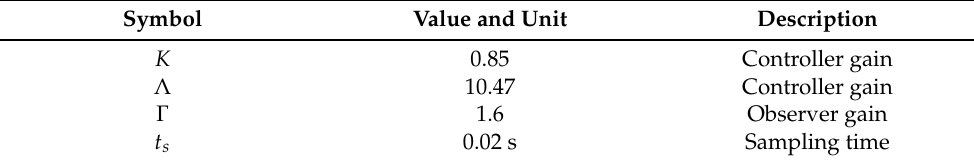
Table 4. Controller gains, observer gains, and camera data sampling time used in the experiment.